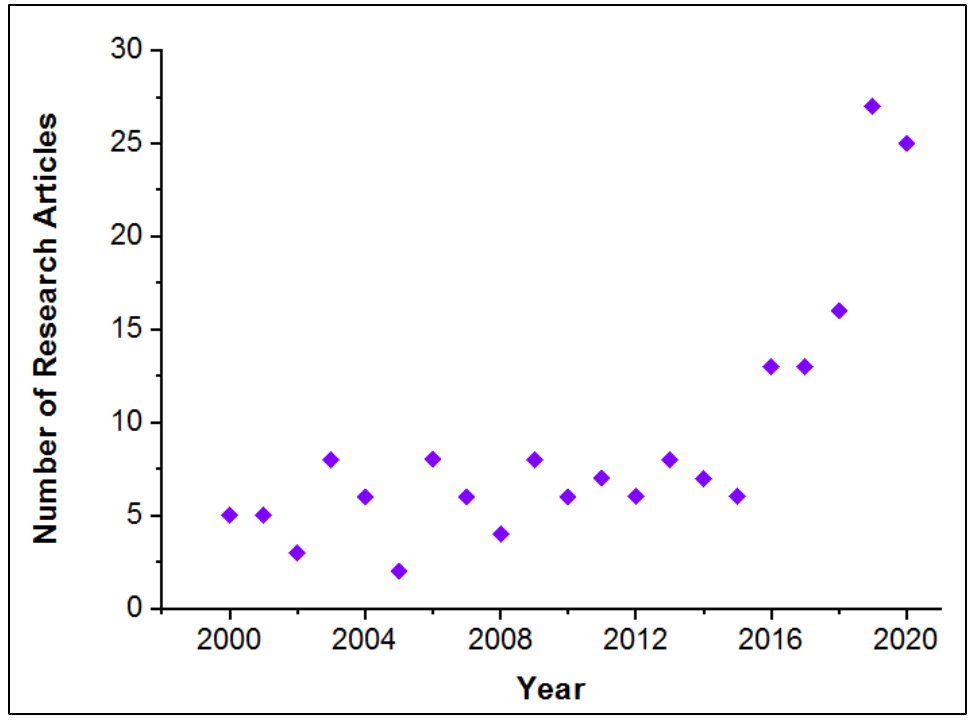
Figure 1. Research articles within the last twenty years in wear of varied fibre volumetric fractions (Two keywords used: “fibre volume fraction” and “wear”—Database used: www.sciencedi- rect.com, accessed on 5 December 2022) .